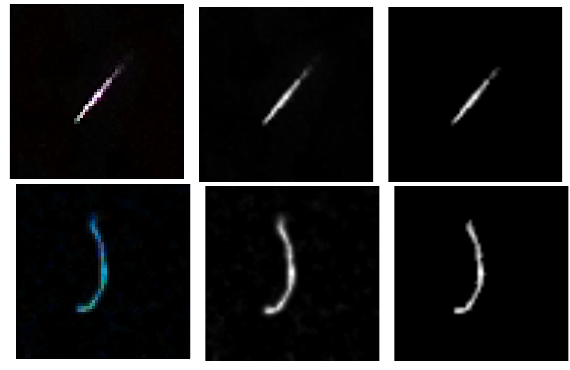
Figure 8. Original track ( upper row ) and worm ( lower row ) and their grayscaled and thresholded